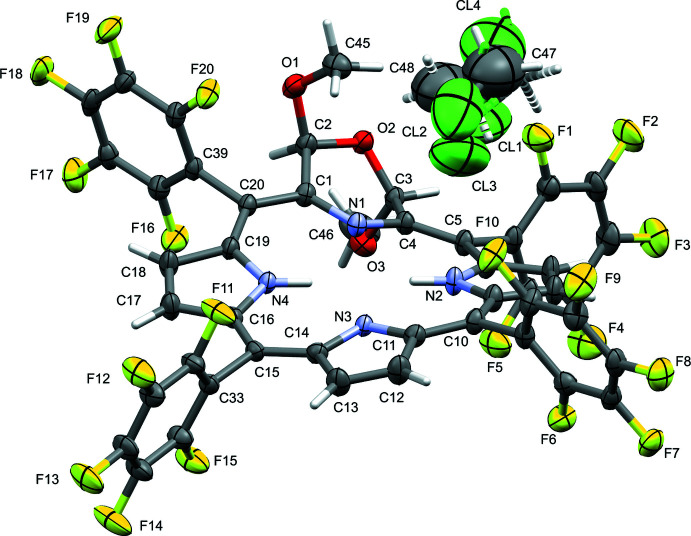
The structure of 1d with the atom-labeling scheme. Probability ellipsoids are drawn at the 50% level. Symmetry-created atoms are shown in capped-stick mode and are unlabeled. Dashed bonds indicate minor moiety disordered and symmetry-related atoms. Some carbon atom labels are omitted for clarity.